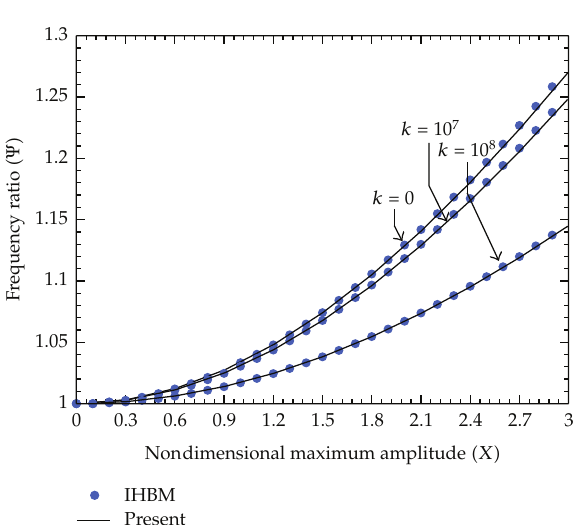
Figure 2: E ff ect of spring constant k on nonlinear amplitude frequency response curves of TWNT.